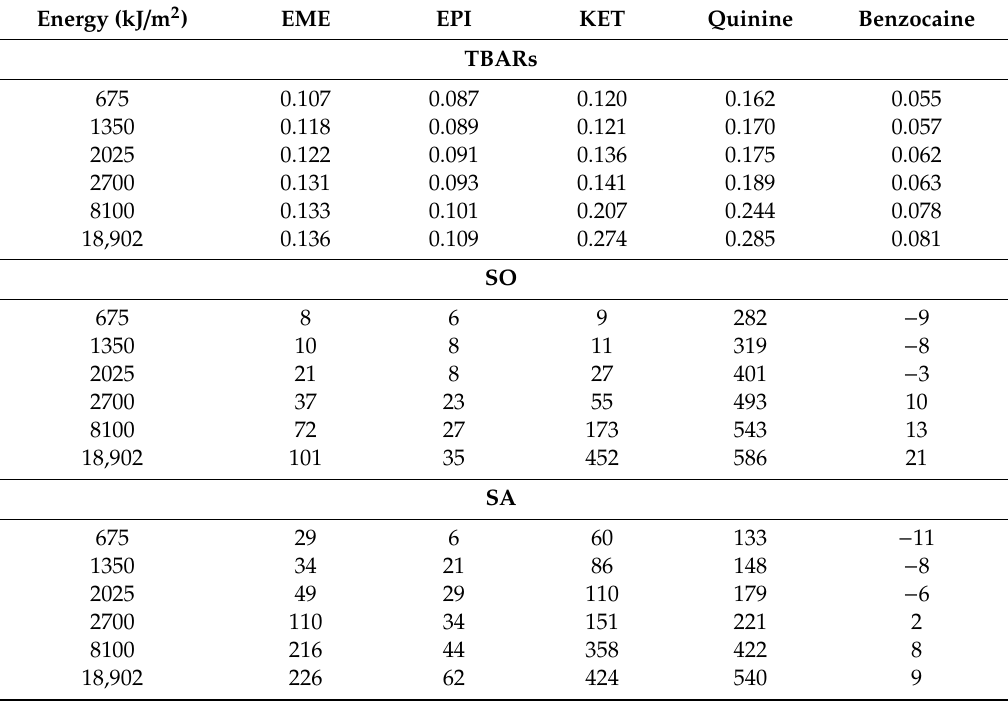
Table 6. Results of the ROS tests of emedastine (EME), epinastine (EPI), and ketotifen (KET) versus quinine as a positive control and benzocaine as a negative control ( n =